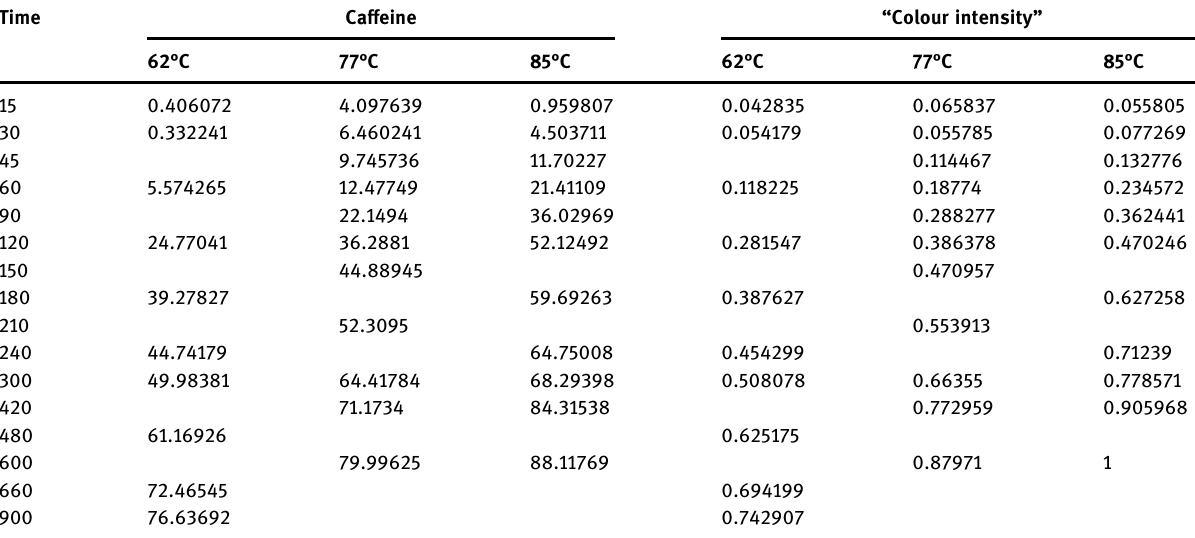
Table 1: Data summary of both measured ca ff eine ( mg/100 mL ) and normalized